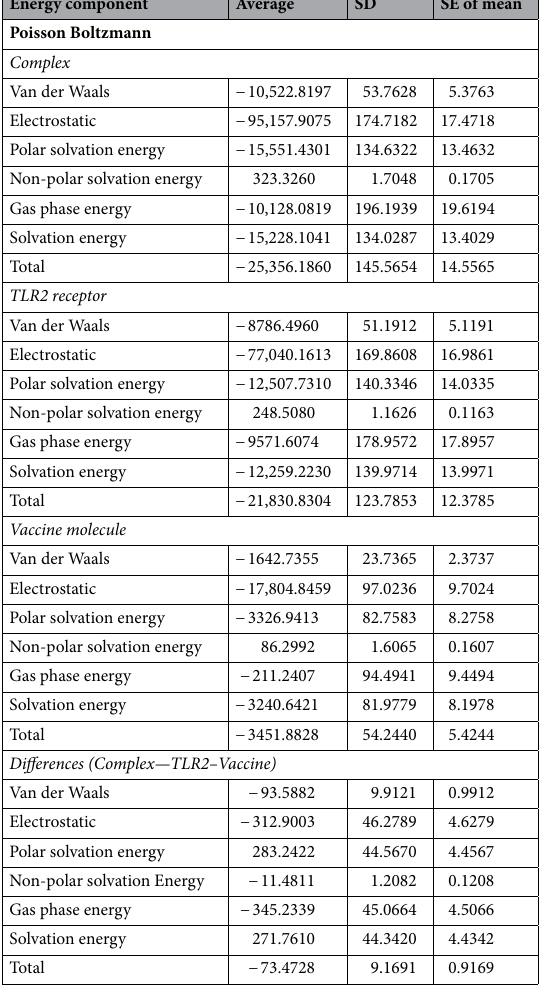
Table 3. MMPBSA based binding free energies of the complex, TLR2, vaccine and net delta energy in kcal/